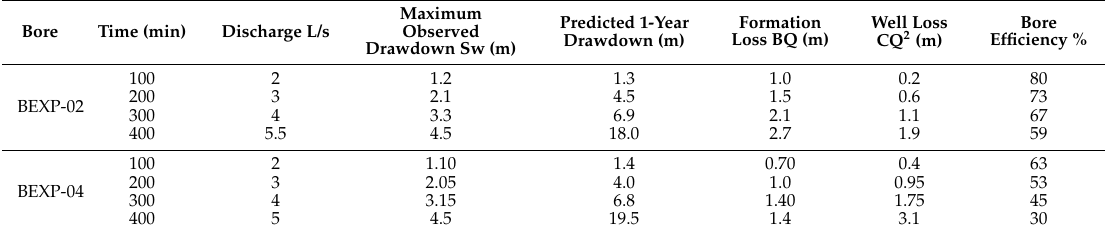
Table 2. Results of step drawdown tests at selected bores.